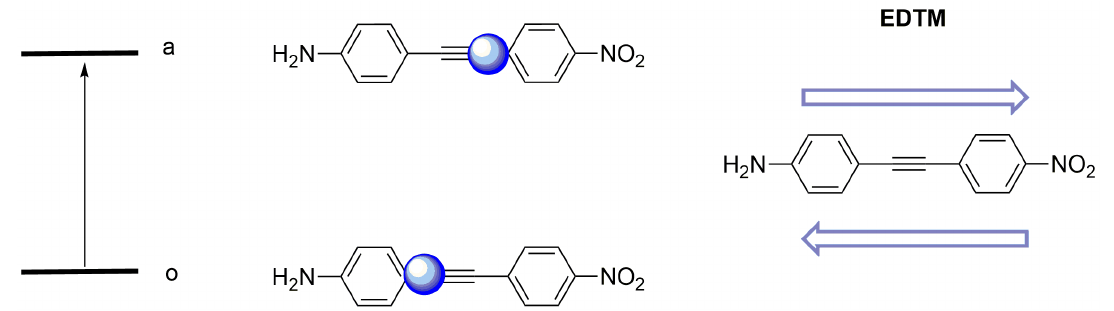
Scheme 3. Representation of the o → a electronic excitation of a model compound. The electron density redistribution from the ground state o to the excited state a results in the Electric Dipole Transition Moment (EDTM). EDTM has a defined direction and two equally-probable orientations. The blue spheres represent the center of electron density for the electronic